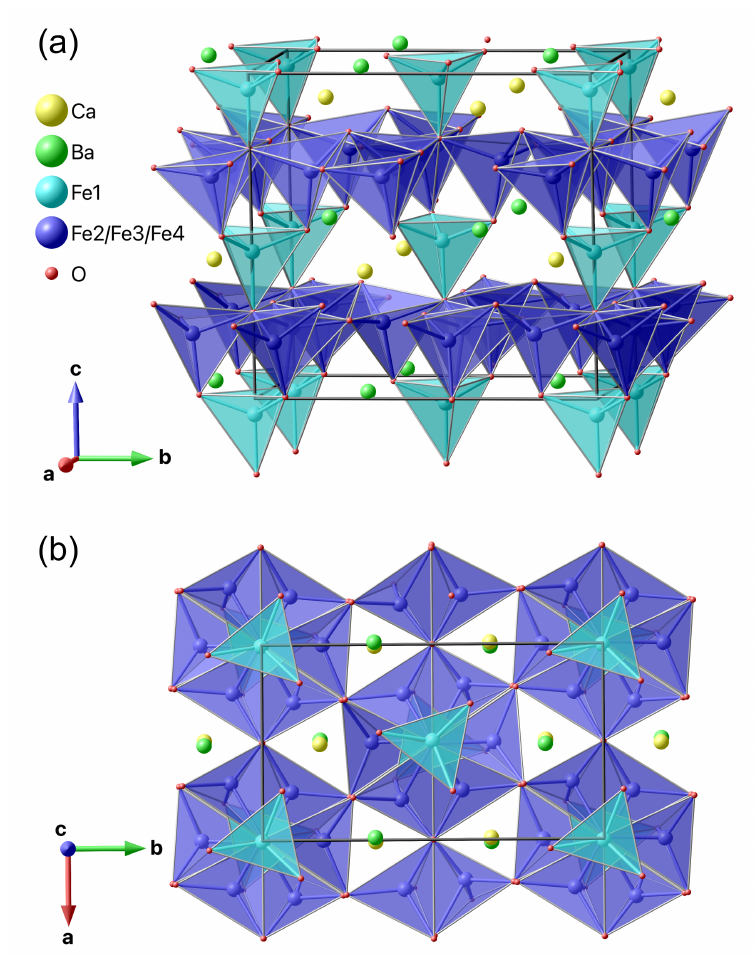
Figure 1: (a) Visualization of the crystal structure of CaBaFe angular Fe sites (light blue) and hexagonal Fe sites (dark blue), where the latter form the kagome planes within the a - b plane. (b) View along the c axis emphasizing the close-to hexagonal symmetry and the two different types of triangles within the kagome planes as described in the